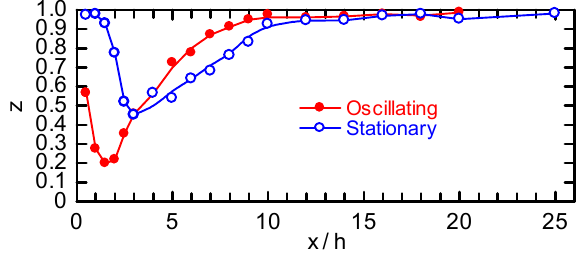
Fig. 13 Streamwise variation of randomness